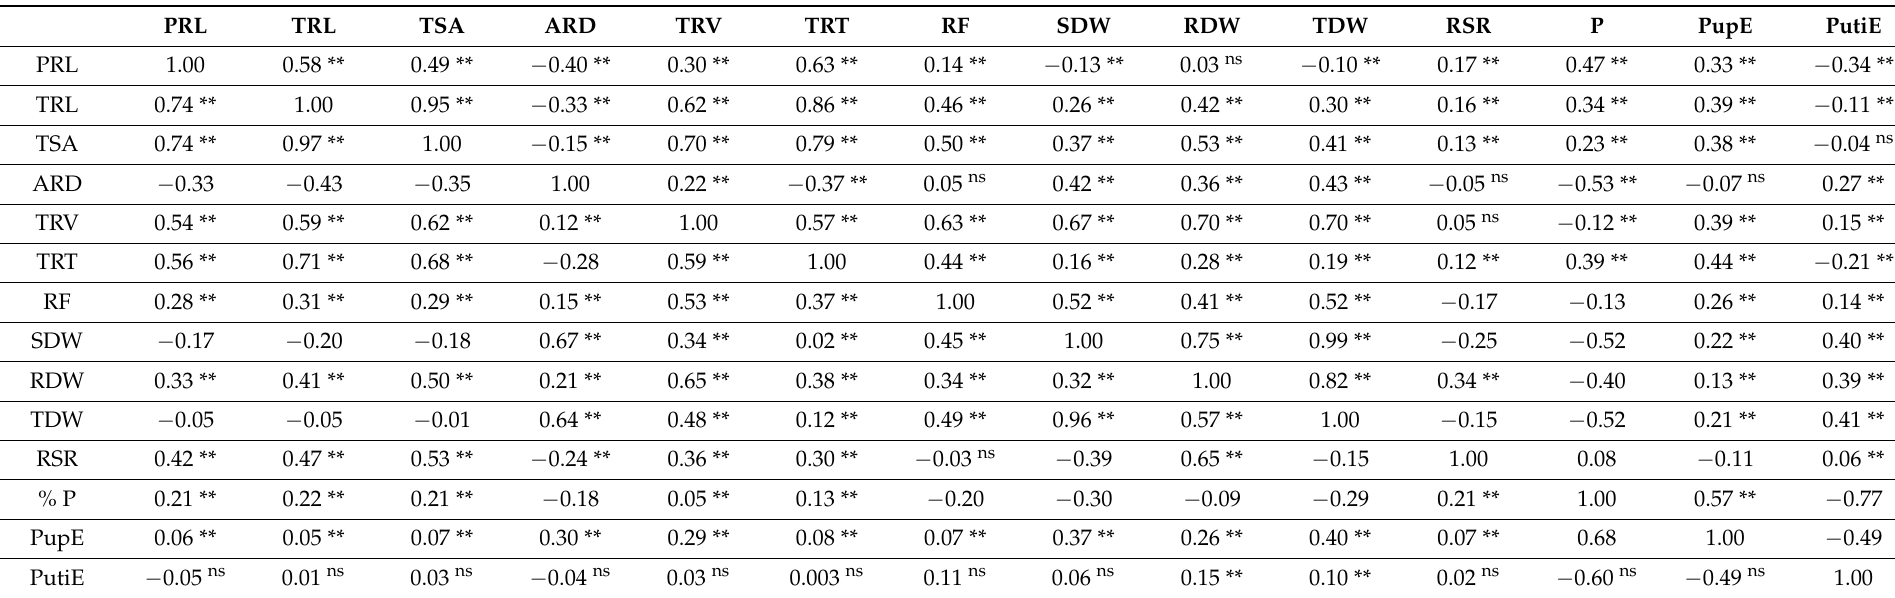
Table 3. Pearson’s correlation analysis for the studied root and shoot traits under optimum-phosphorus (upper diagonal) conditions and low-phosphorus (lower diagonal)